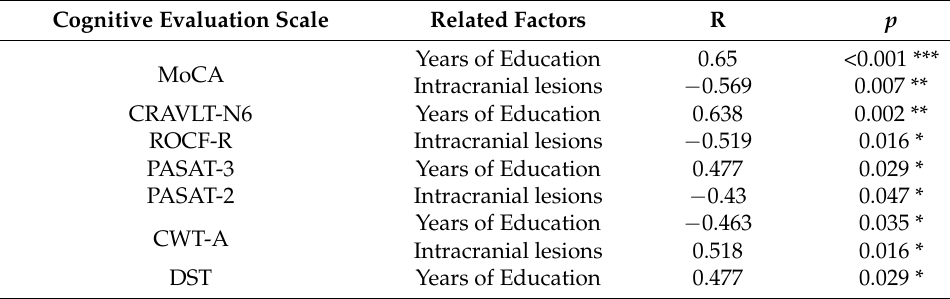
Table 6. Correlation factor